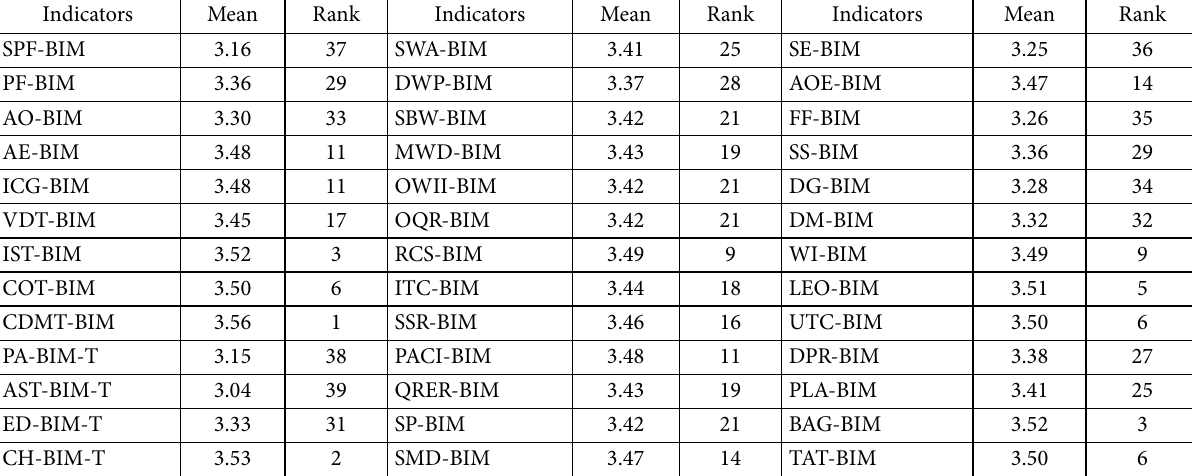
Table 3. Ranking of the